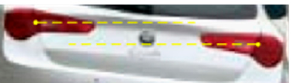
Figure 10. Centroid of the taillight areas.